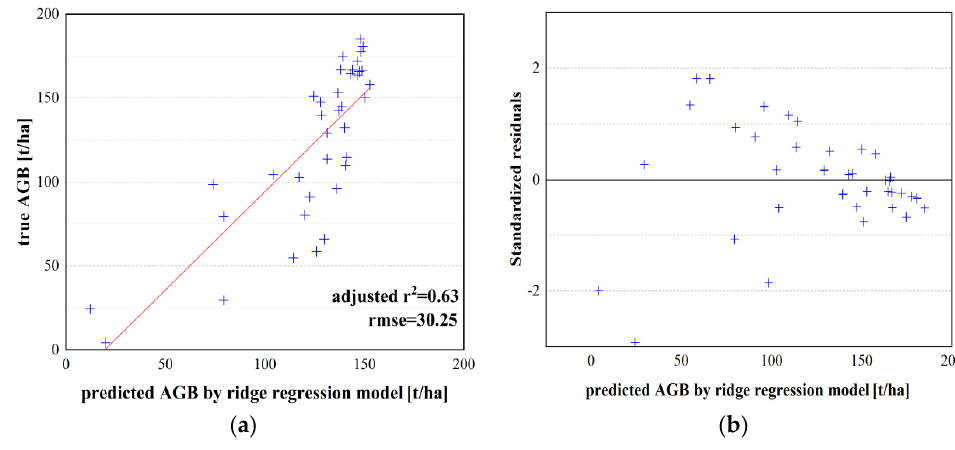
Figure 8. ( a ) Ridge regression model; ( b ) residual analysis graph.